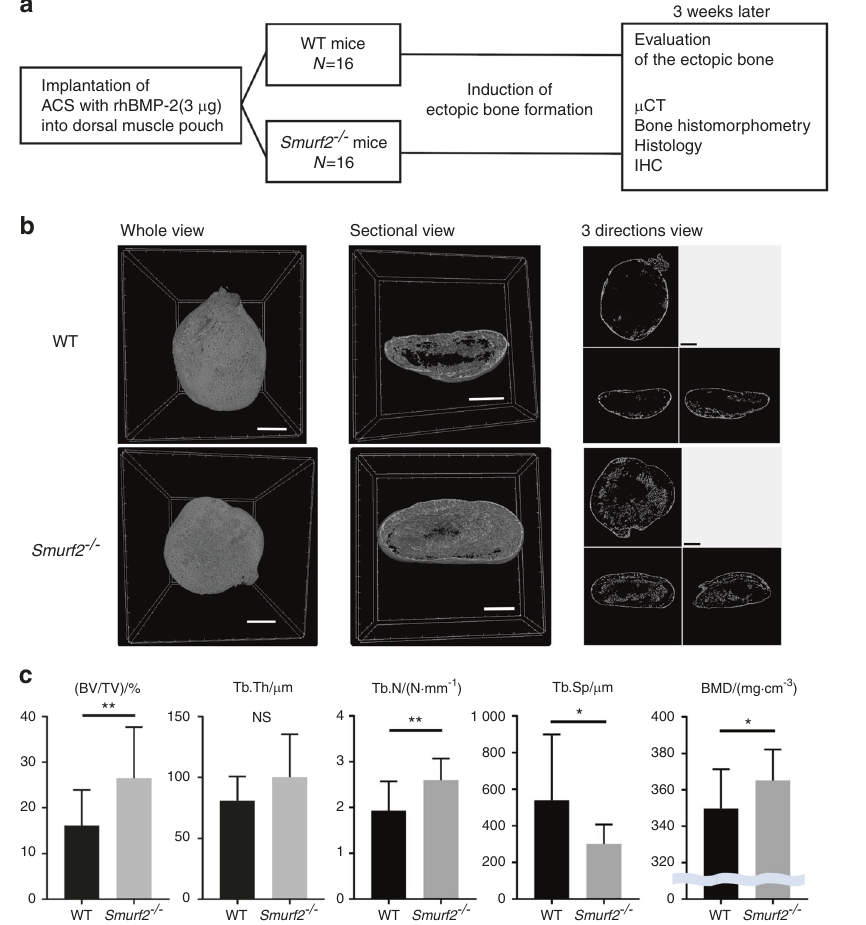
Fig. 2 rhBMP2-induced ectopic bone formation model. a Schematic of the experimental design. b 3D micro-CT image of rhBMP2-induced ectopic bone (scale bar = 1 mm). c Micro-CT analysis of rhBMP2-induced ectopic bone. ( n = 16 per genotype; * P < 0.05; ** P < 0.01; NS, not signi fi cant by Student ’ s t